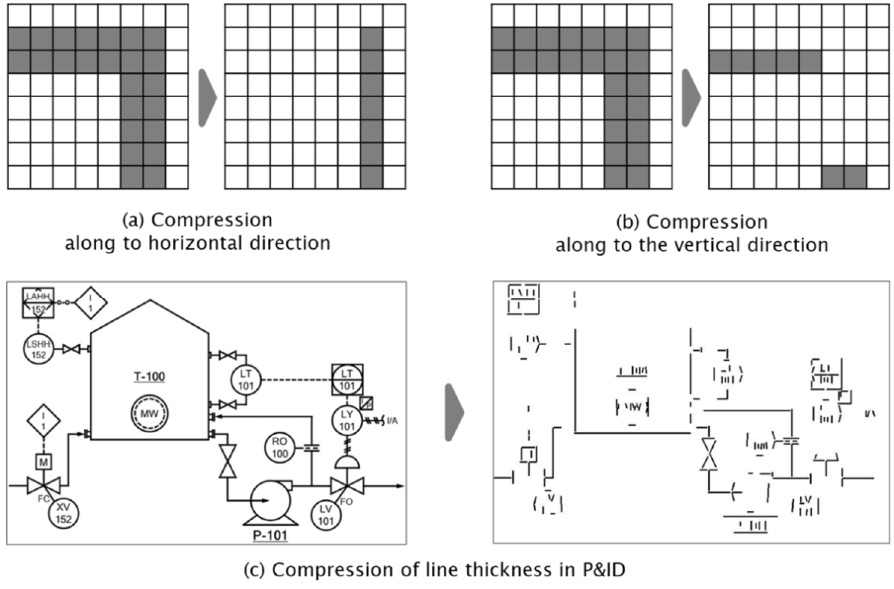
Figure 10. Compression of line thickness in P&ID.